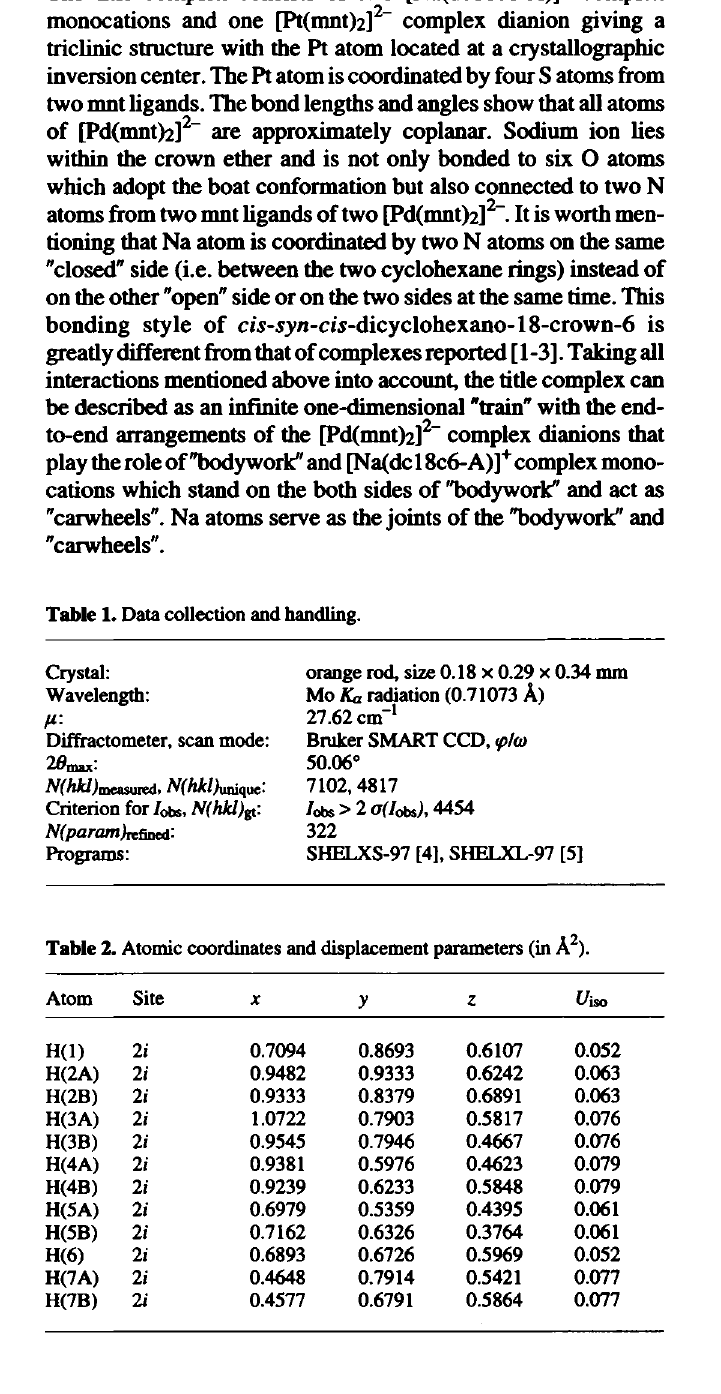
Table 2. Atomic coordinates and displacement parameters (in À 2